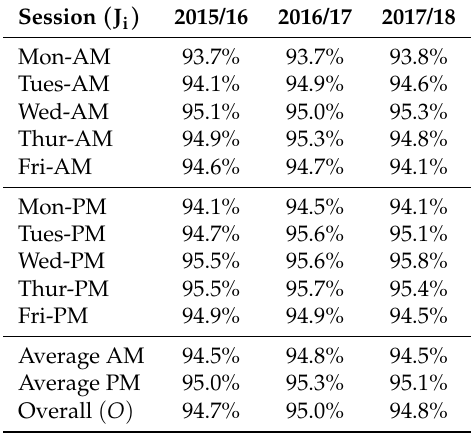
Table 1. Average attendance for 2015/16, 2016/17, and